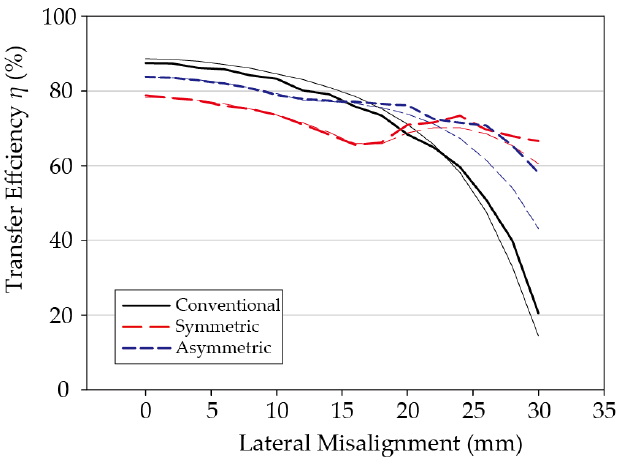
Figure 7. Comparison of the symmetric and asymmetric multilayer coil systems with the conventional system: simulated (thin) and measured (thick) results.